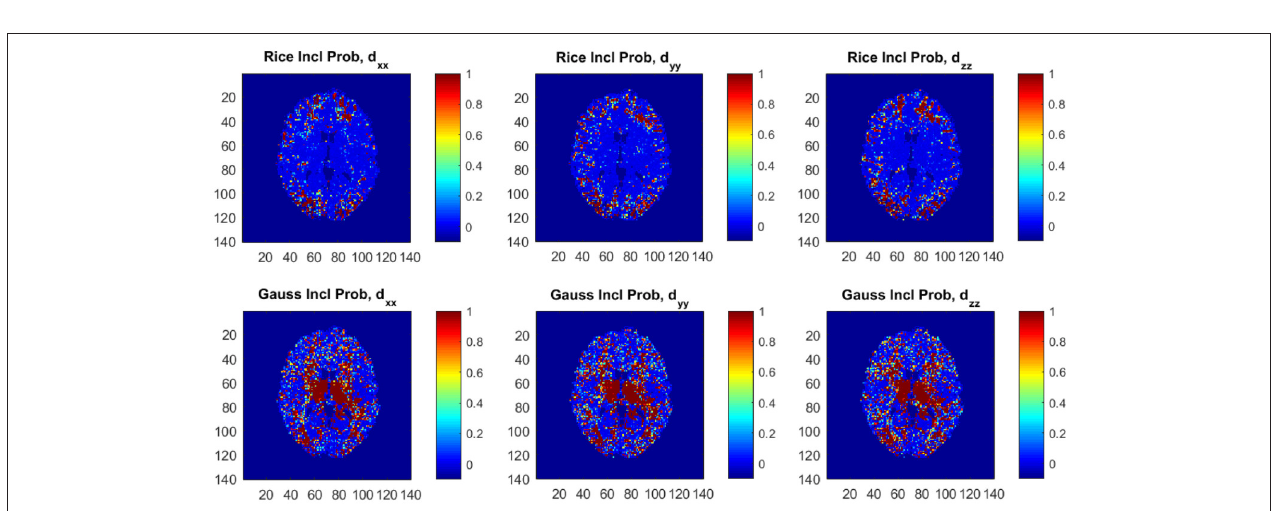
d xx , d yy , d zz (cid:0)